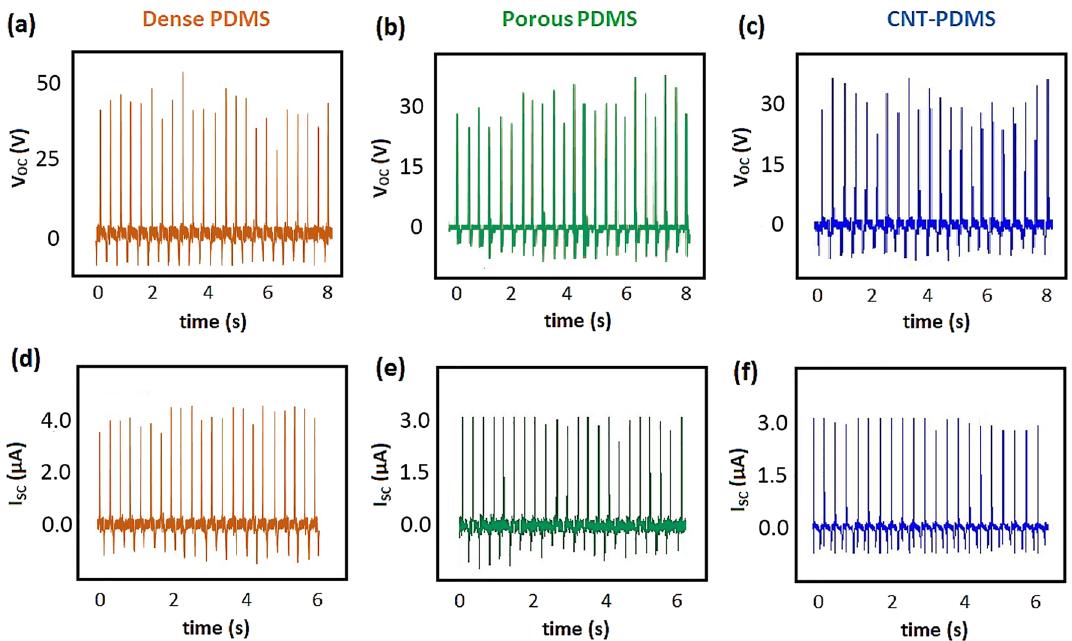
Figure 5. Generated voltage and current for TENGs based on dense PDMS ( a and d ), porous PDMS ( b and e ), and CNT-PDMS ( c and f